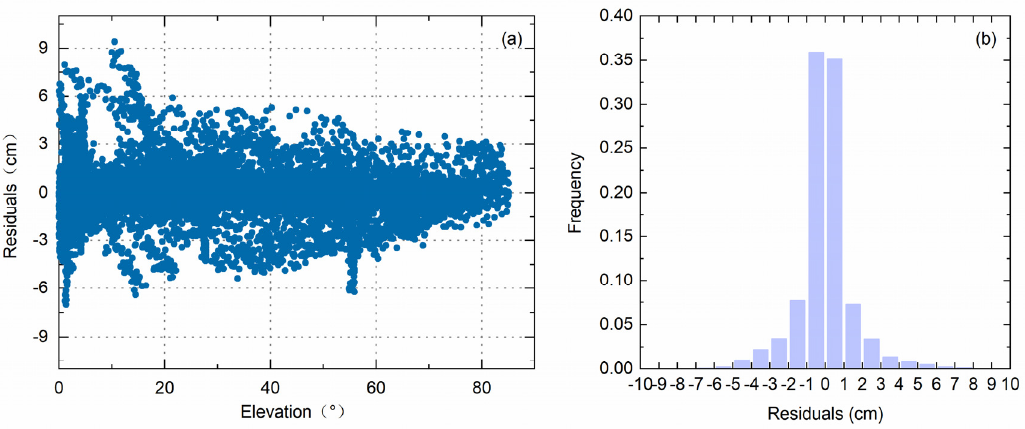
Figure 11. The statistic results of precise orbit determination (POD) residuals. ( a ) The relationship between POD residuals and the elevation angle. ( b ) Frequency distribution histogram of POD residuals.